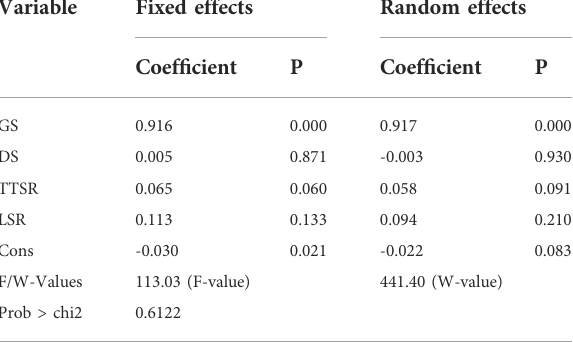
TABLE 6 Patent output regression